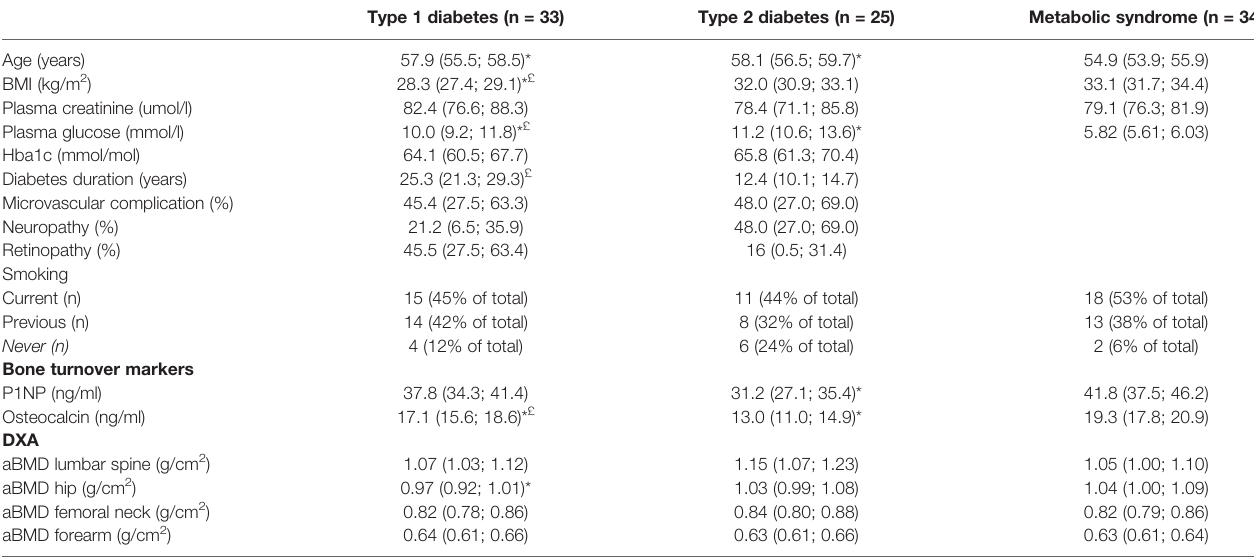
TABLE 1 | Characteristics, dual-energy X-ray parameters and bone turnover markers of included